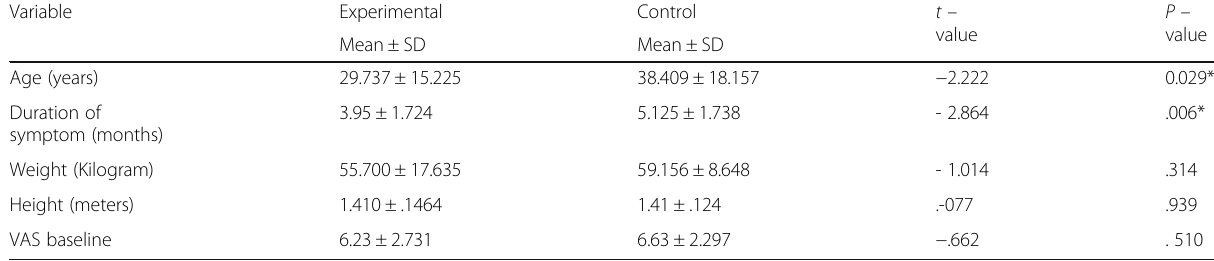
Table 2 Baseline mean comparison of age, duration of symptom, weight, height and visual analogue scale Variable